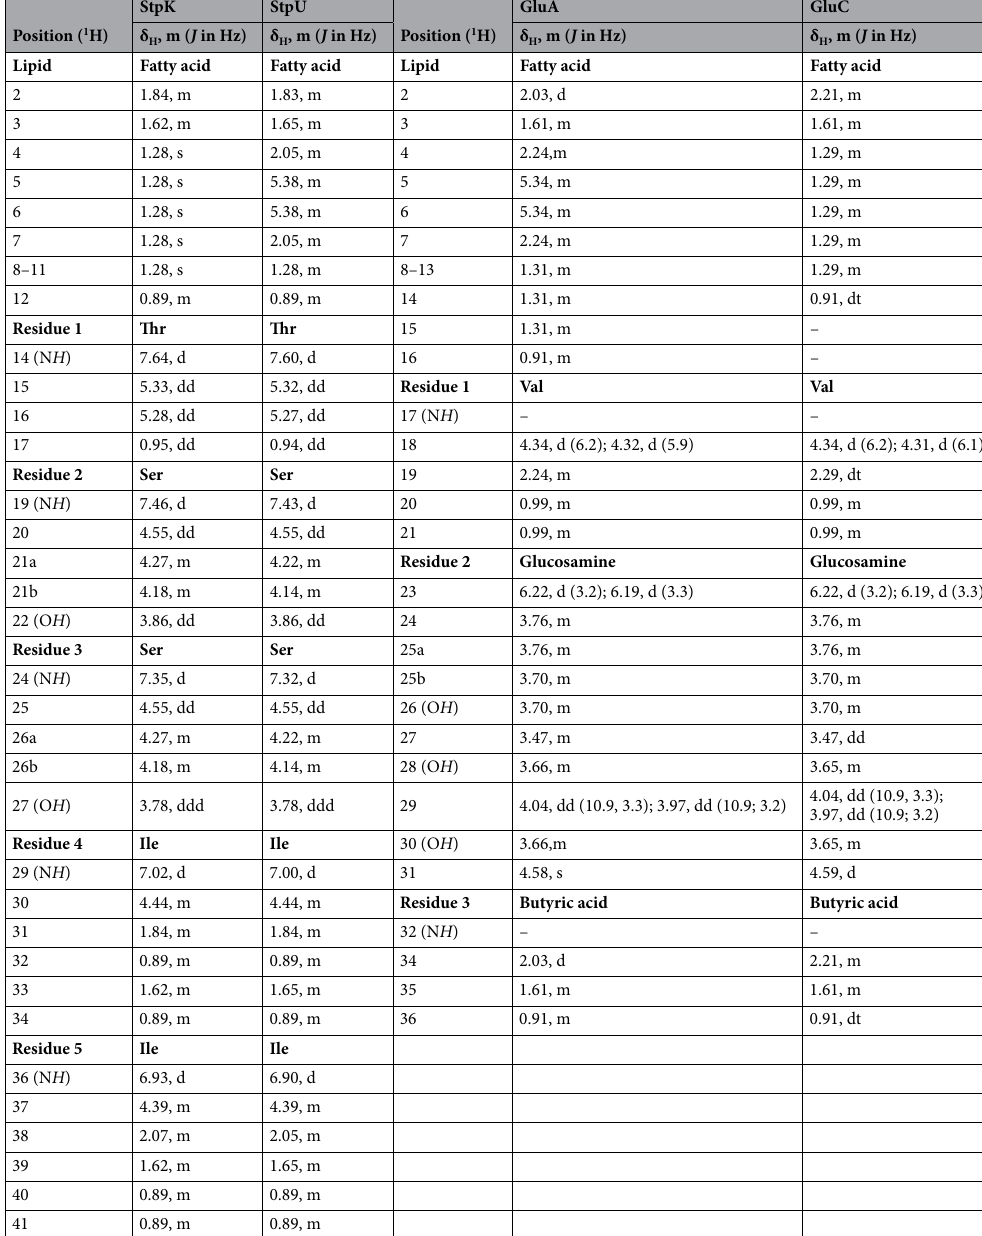
Table 2. The 1 H NMR Data (600 MHz) for StpK and StpU (in CD 3 CN), as well as GluA and GluC (in CD 3 OD). Refer to Fig. 3 for the atom numbered